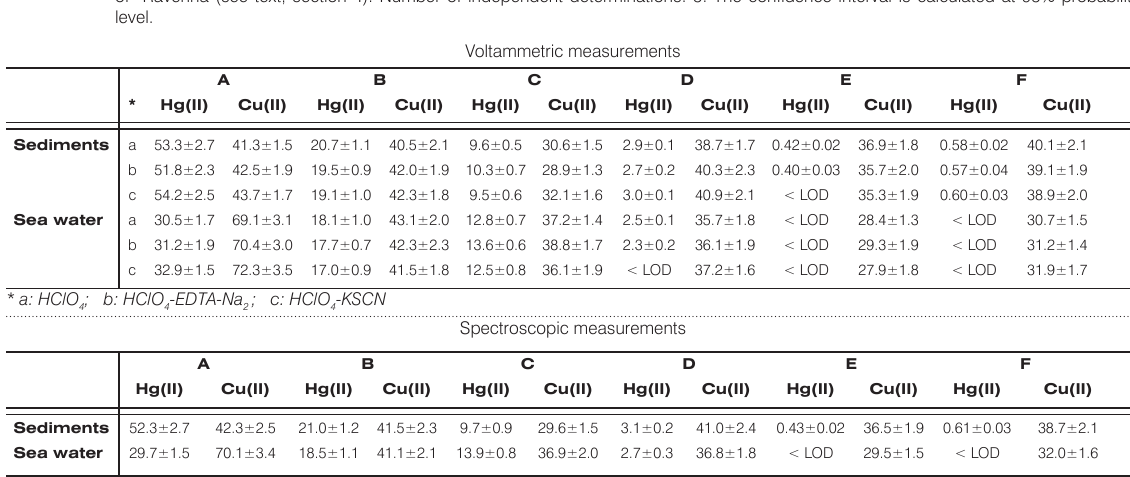
Table 6. Mean values of Hg(II) and Cu(II) concentrations relevant to sediments (μg g -1 ) and sea waters (μg L -1 ) sampled in the Lagoon ecosystem of Ravenna (see text, section 4). Number of independent determinations: 5. The confidence interval is calculated at 95% probability